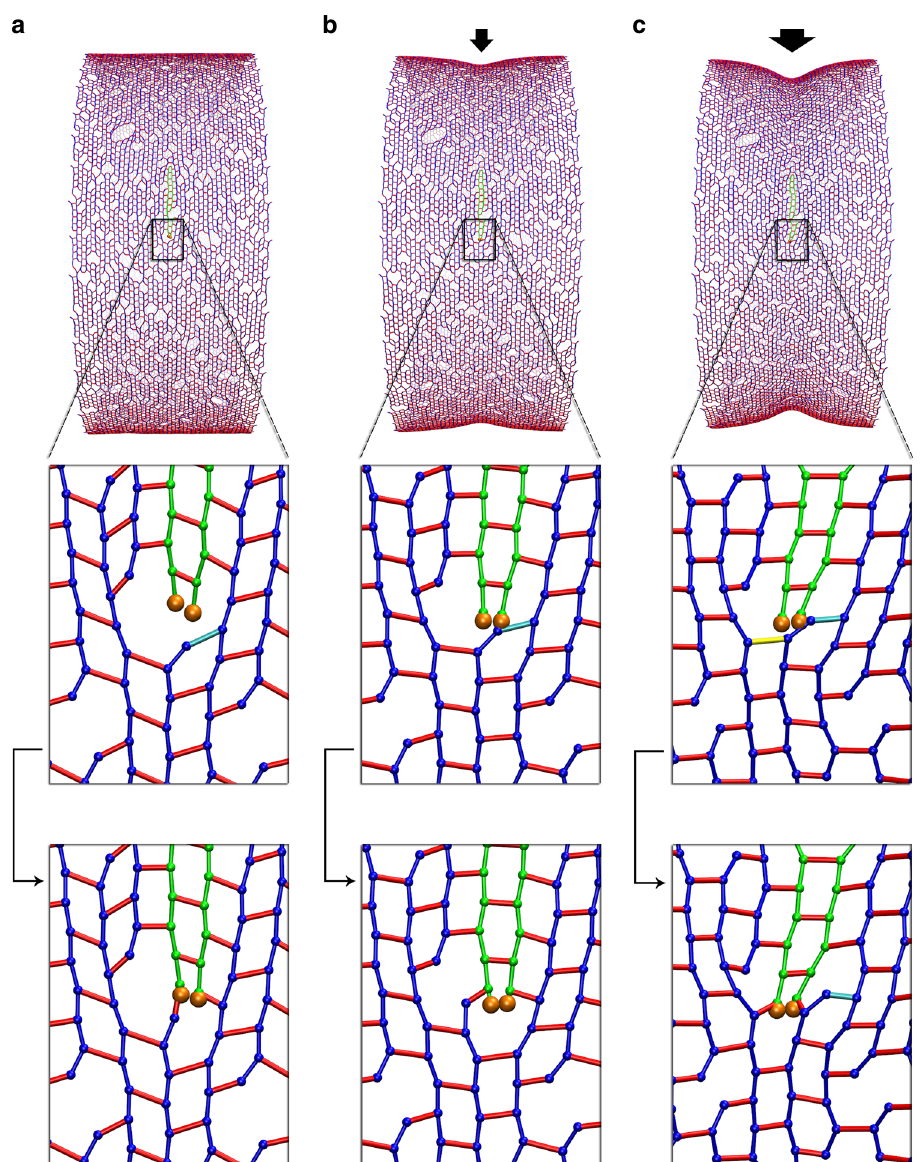
Fig. 3 Detailed effect of the constrictive force. The arrows between the zoomed-in views in the bottom two rows indicate the time sequence of events. a Without the force, the new strand tips were at some distance from the existing crosslink that was targeted for cleavage (highlighted in cyan). After the target crosslink was cleaved, new peptidoglycan (PG) was matched one-to-one with the existing template. b In the presence of a small force, the midcell was squeezed, pulling the new strand tips closer to the target crosslink (highlighted in cyan). After the target crosslink was cleaved, the new PG was still matched one-to-one with the default template. c In the presence of a large force, the new strand tips were pulled past the default target crosslink (highlighted in cyan), therefore skipping it, and an upstream crosslink (highlighted in yellow) became the new target. After the new target crosslink was cleaved, the new PG was no longer matched one-to-one with the template. Note that several such template-skipping events occurred along each